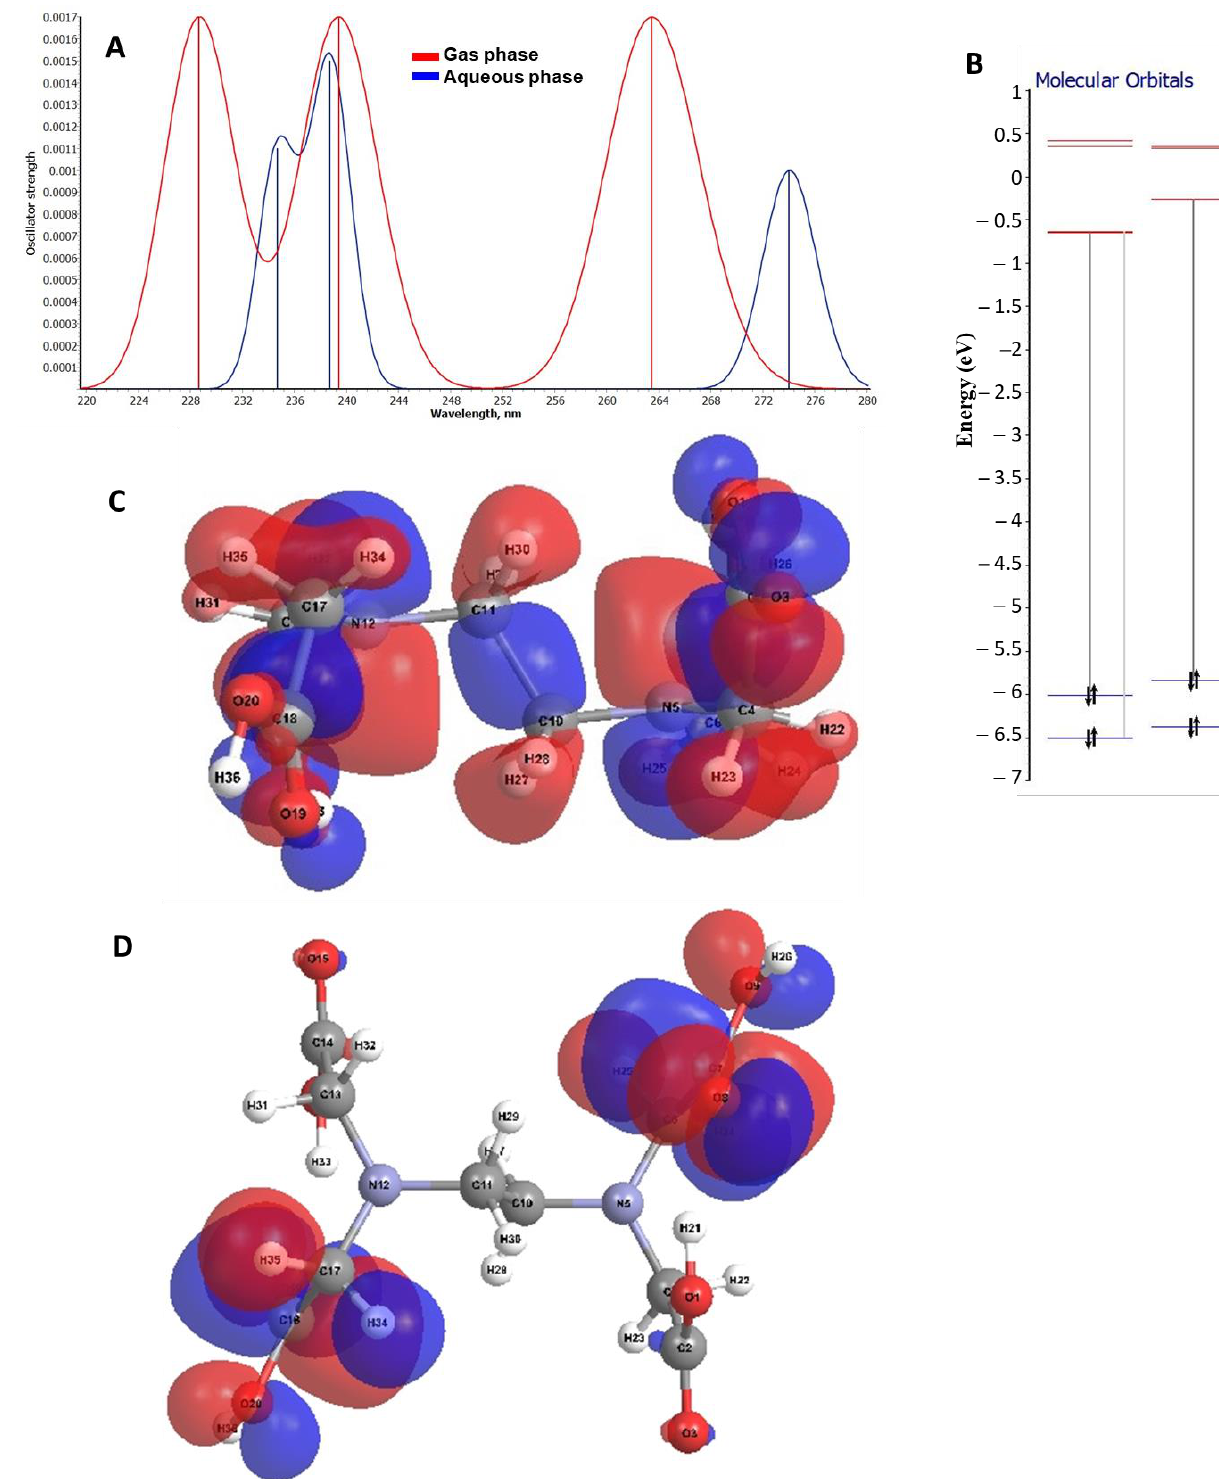
Figure 12. ( A ) Theoretical electronic spectrum for the most energetically stable EDTA conformer corresponding to both gas and aqueous phase. ( B ) Fragment from the energy diagram illustrating electronic transitions between boundary levels for EDTA structure: (a) gas phase; (b) aqueous phase. The spatial representation of the boundary orbitals for EDTA structure in gaseous phase ( C ) HOMO and ( D ) LUMO.